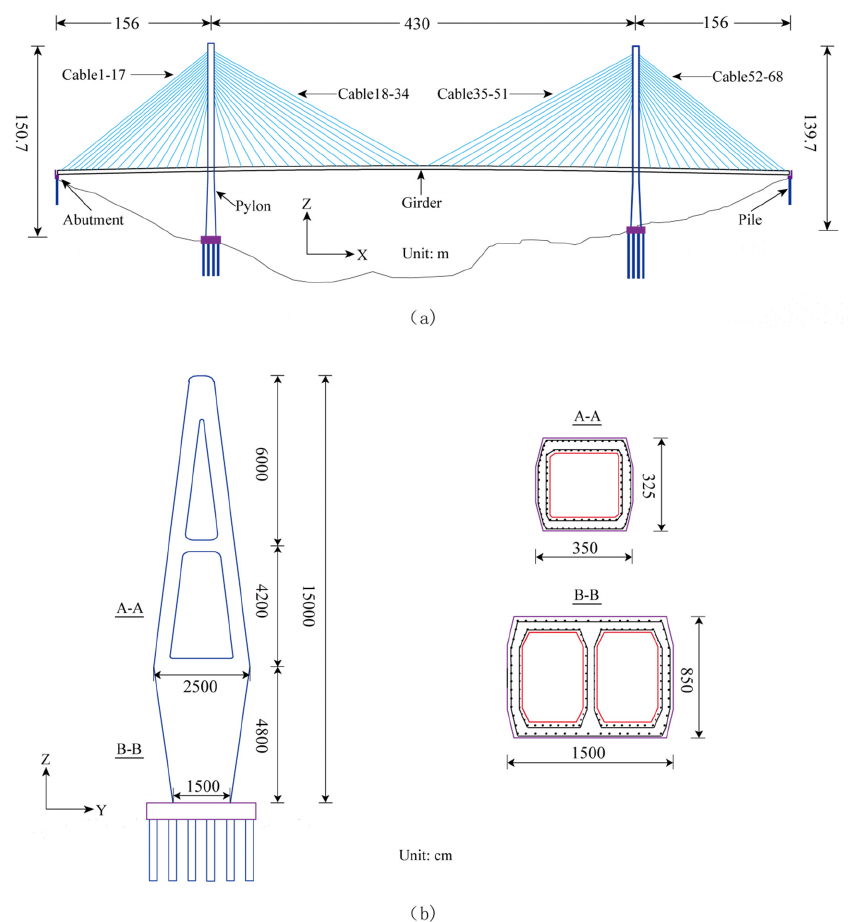
Figure 1. General view of the prototype bridge: ( a ) longitudinal geometry of the bridge; ( b ) geometry of the bridge pylon.